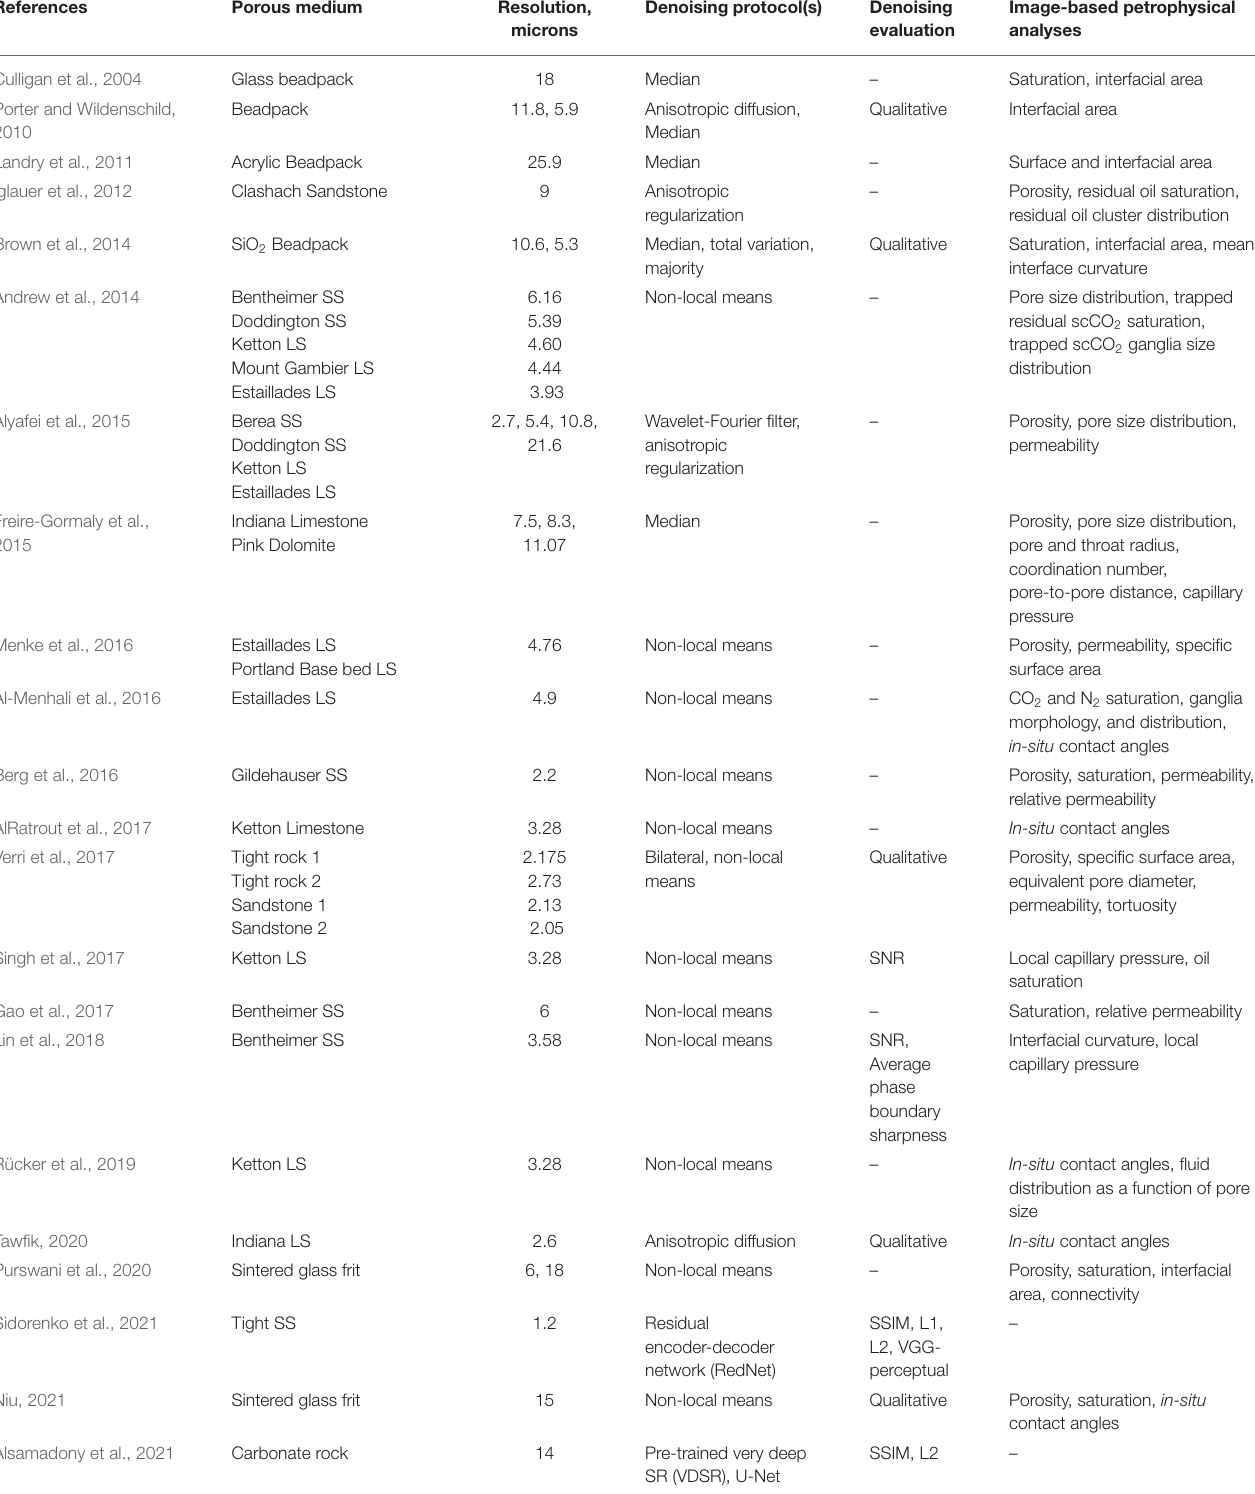
TABLE 1 | A summary of selected publications that report on MCT imaging in the digital rock physics domain, highlighting the commonly used denoising